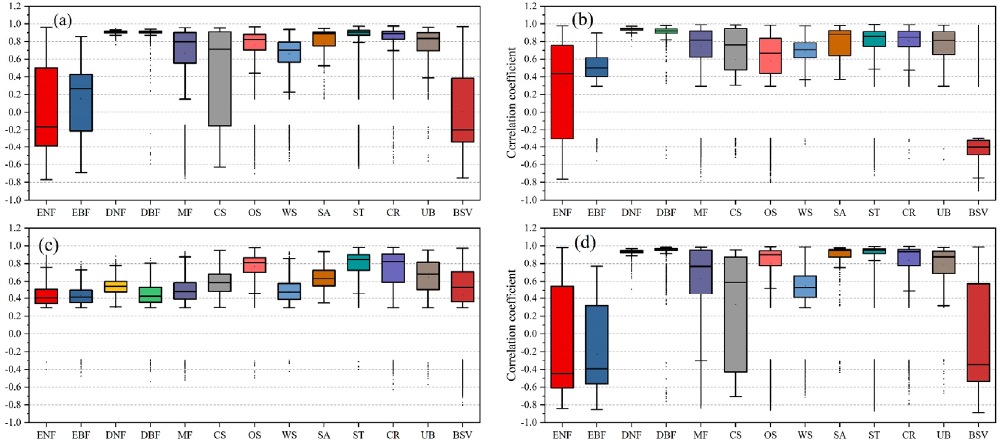
Figure 3. Seasonal PCC values obtained between NDVI and SIF for different land-cover types: ( a ) growing season; ( b ) spring; ( c ) summer; and ( d ) autumn.